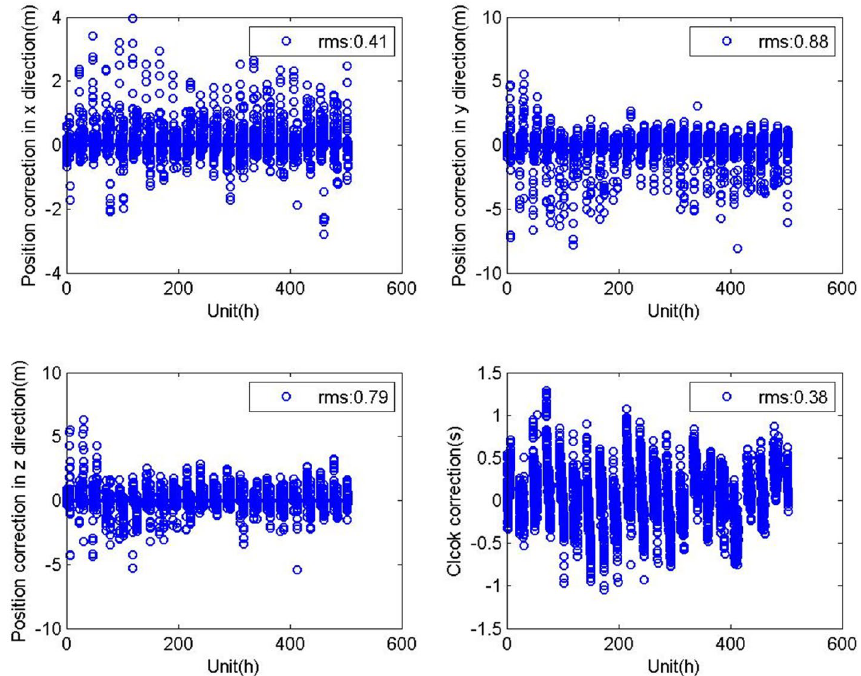
Figure 4. Positioning and clock correction information of the PRN20 satellite broadcasted from Dec 11 to 31, 2020 (top left: broadcasted position correction parameters in the x direction; bottom left: broadcasted position correction parameters in the z direction; top right: broadcasted position correction parameters in the y direction; bottom right: broadcasted clock correction